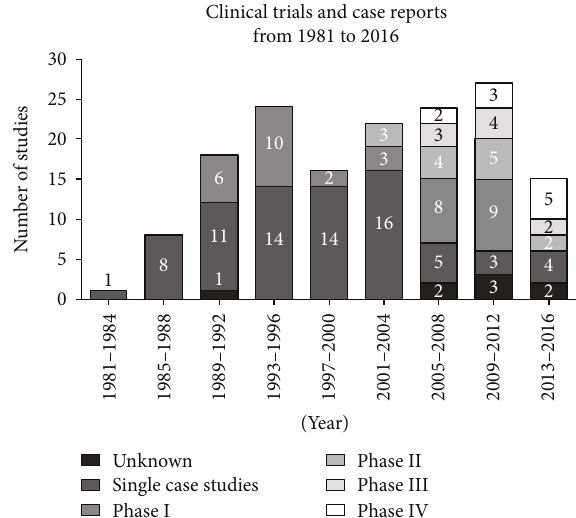
Figure 1: Number and type of clinical trials for stem cell-based skin regeneration since 1980. Single-case studies or small series of single cases were the main clinical activities reported before